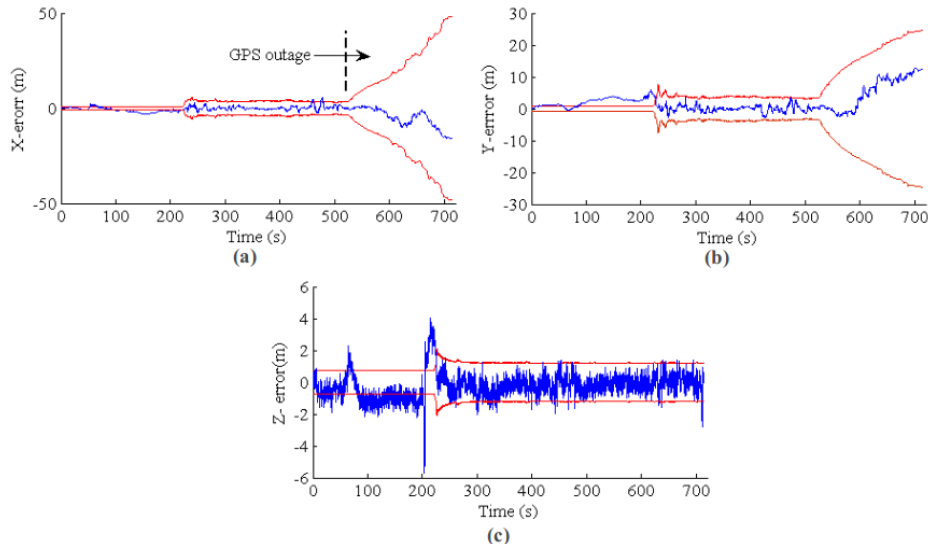
Figure 19. EKF state estimation for a long-term GPS outage from 500 s to the end. The blue line is the estimation error, and the red line is the 3 σ error band. ( a – c ) The results for X , Y and Z ,